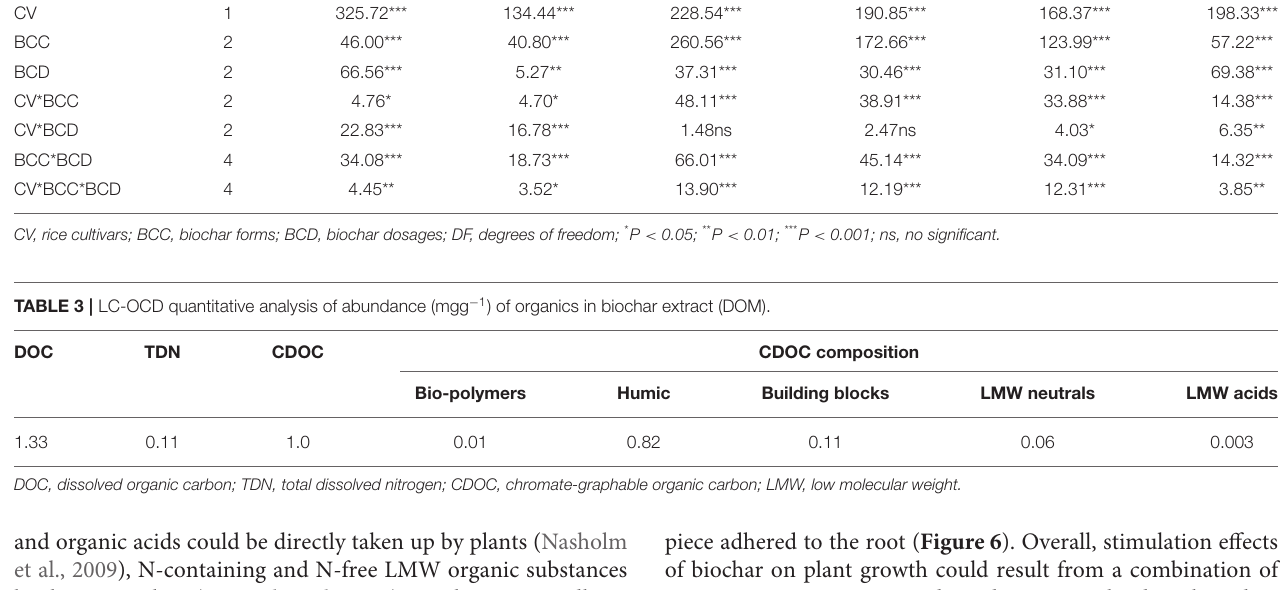
TABLE 2 | ANOVA table displaying F -values for plant shoot and root biomass, and root length, surface area, volume, and tips with three factors and all interactions across Experiment 1. Effect test Length